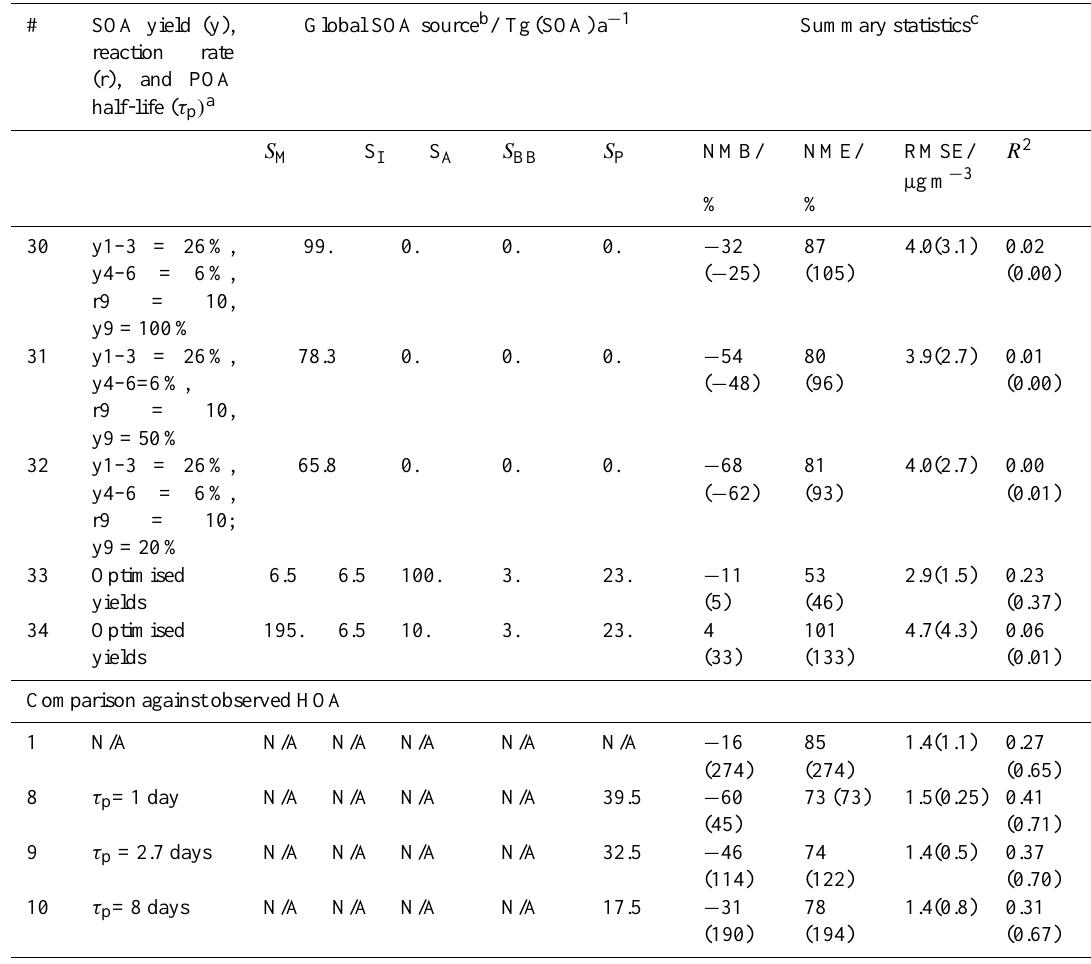
a Reactions specified in Table 1. SOA yields (y1-y10) are defined as the SOA mass formed as a fraction of the emitted VOC mass expressed as a percentage. They are specified when they are non-zero. In simulations 16-18 POA is aged to SOA assuming a first order rate constant. We specify the half life ( τ p ) of POA with respect to ageing to SOA. b Conversion factor of 2 Tg (SOA): 1 Tg (C).